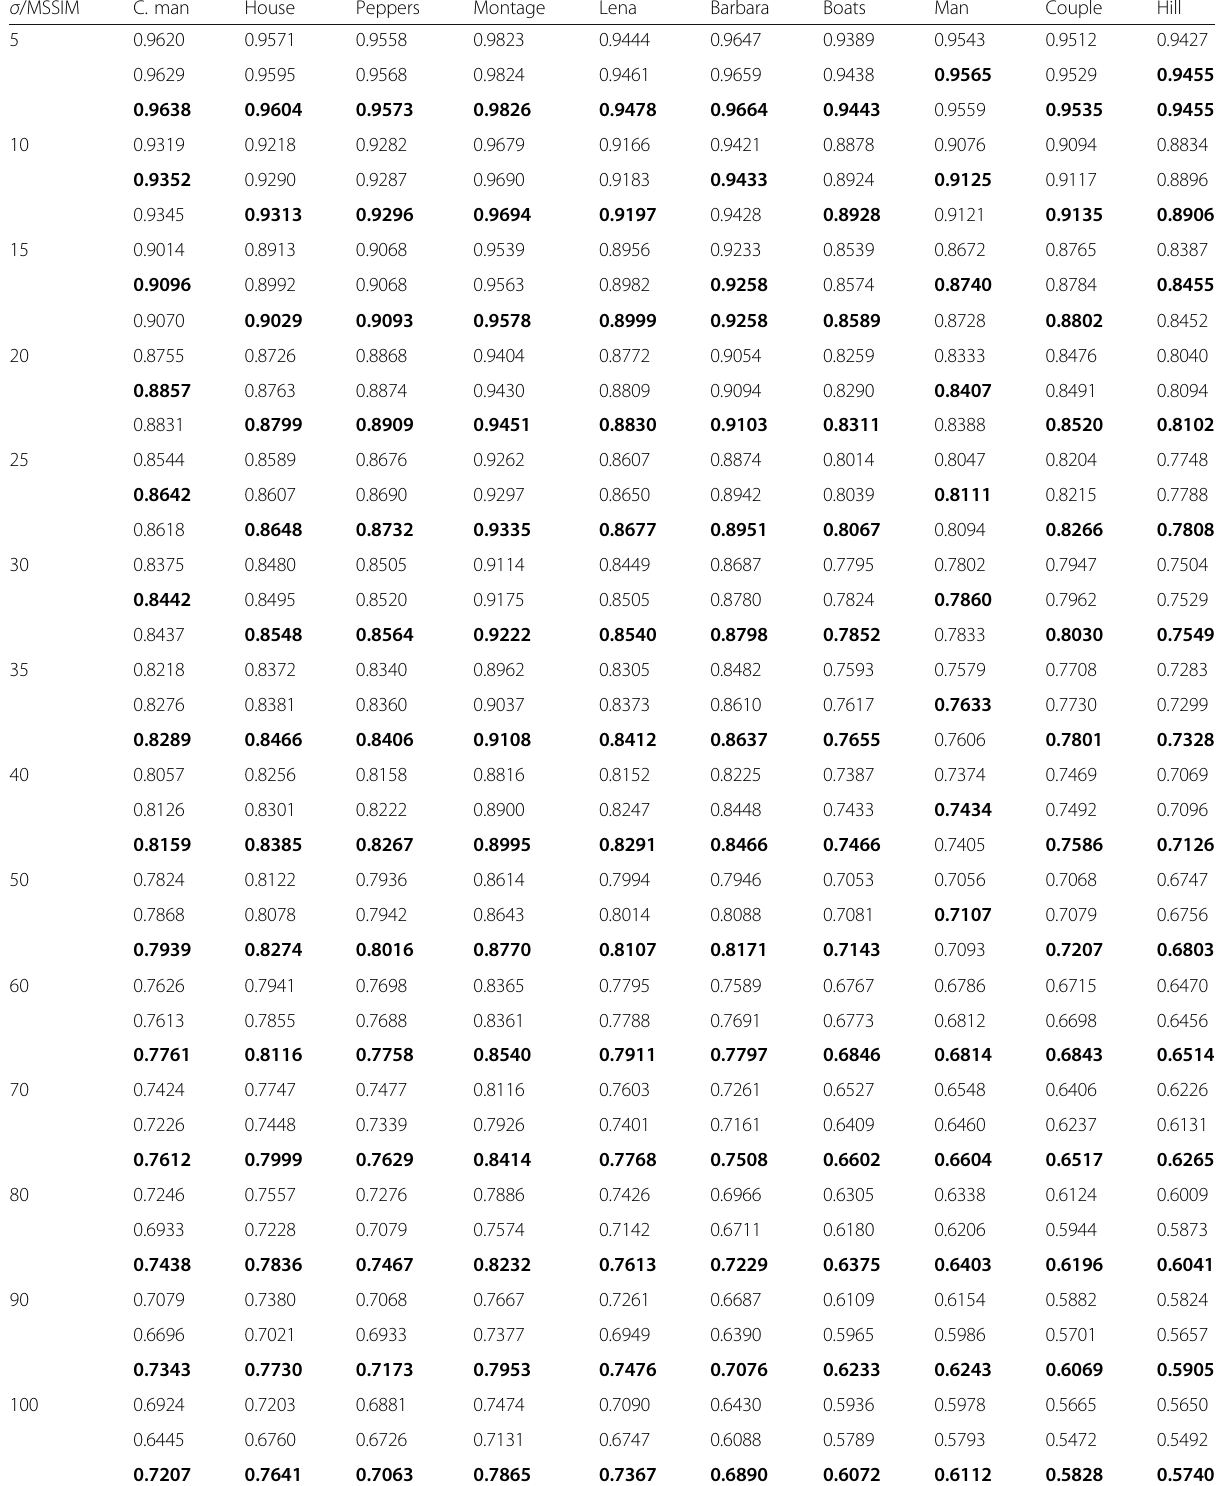
Table 3 Comparison of MSSIM values obtained by BM3D, BM3D-SAPCA, and SA-BM1-3D. In each cell, the upper number is for BM3D, the middle number is for BM3D-SAPCA, while the lower number is for SA-BM1-3D σ